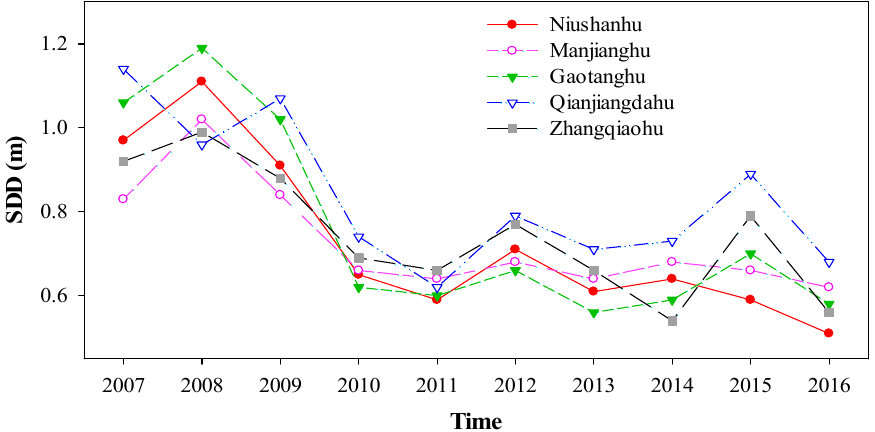
Figure 6. Long-term trend in Landsat retrieved annual mean SDD of five regions in Lake Liangzi during the study.